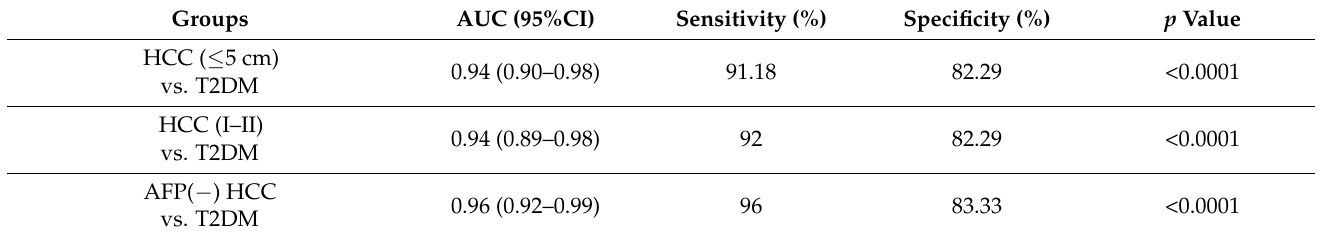
Figure 8. The role of the metabolite classifier in the diagnosis of small–size, early–stage, and AFP( − ) T2DM(+) HCC patients. ( A ) The scores of the metabolite classifier in T2DM(+) HCC patients with small (size ≤ 5) and large (size > 5) tumors compared with T2DM patients. ( B ) The scores of the metabolite classifier in T2DM(+) HCC patients with early-stage (stage I–II) and late–stage (stage III–IV) tumors compared with T2DM patients. ( C ) The scores of the metabolite classifier in T2DM(+) HCC patients with AFP( − ) and AFP (+) tumors compared with T2DM patients. ( D ) The ROC curve of the metabolite classifier for discriminating T2DM(+) HCC patients with small–size tumors from T2DM patients. ( E ) The ROC curve of the metabolite classifier for discriminating T2DM(+) HCC patients with early–stage tumors from T2DM patients. ( F ) The ROC curve of the metabolite classifier for discriminating T2DM(+) HCC patients with AFP( − ) tumors from T2DM patients. AFP, alpha- fetoprotein; T2DM, type 2 diabetes mellitus; HCC, hepatocellular cancer; ROC, receiver operating characteristic. *** p value < 0.001; ns, not significant. Table 6. The diagnostic performance of the metabolite classifier for the detection of small-size, early-stage, and AFP( − ) T2DM(+) HCC.